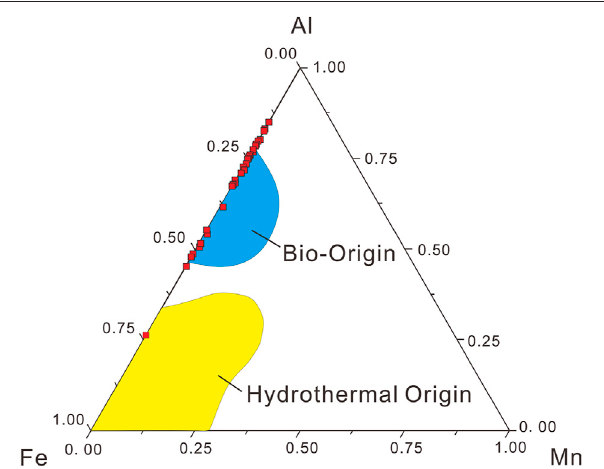
FIGURE4| Thesourceofsiliceousmineralsinthe fi rstmemberofLower Silurian Longmaxi Formation of Jiao Ye 1 Well containing excess silicon content is analyzed by Al-Fe-Mn triangle diagram, indicating that the excess silicon content is biogenesis. See Figure 1 for the well location.